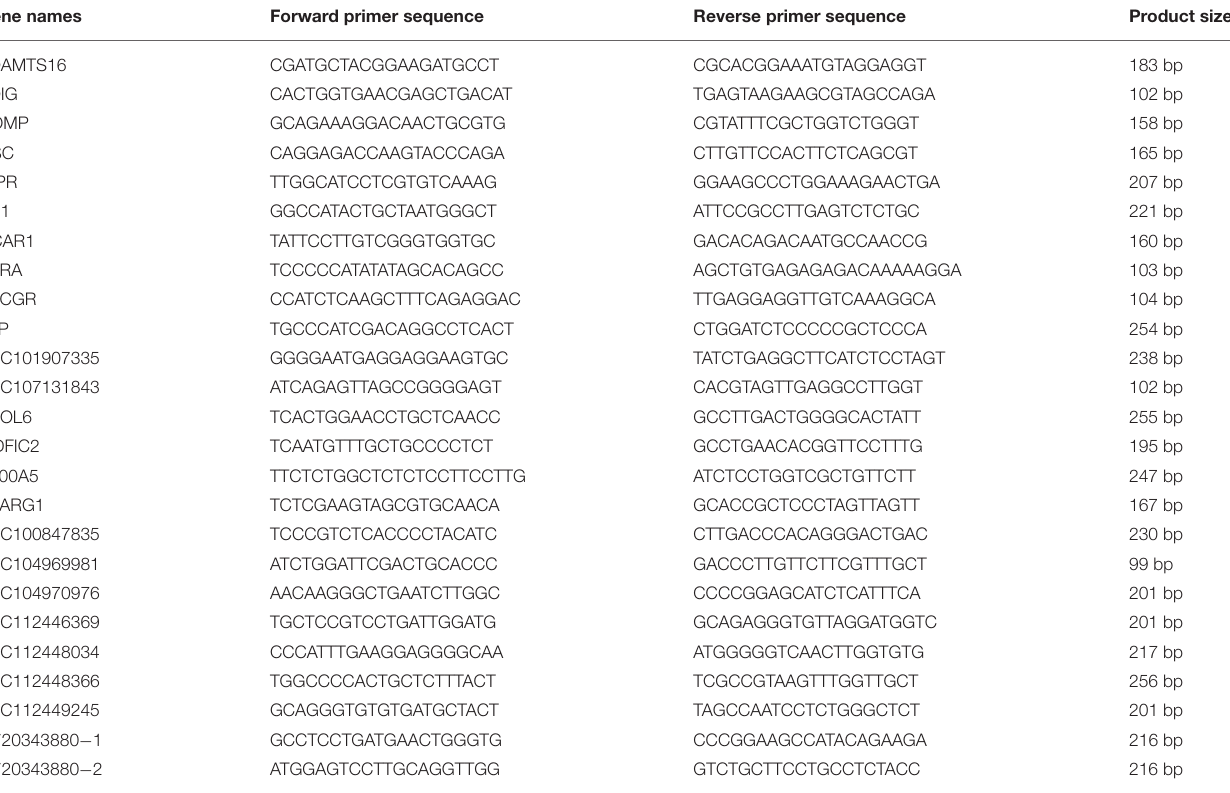
TABLE 1 | Primers used in this